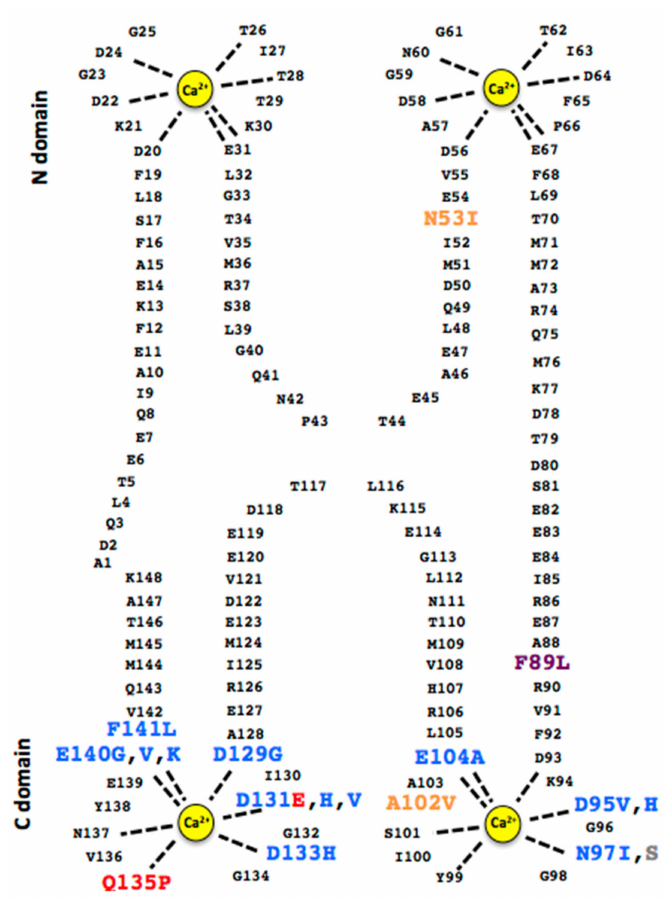
Figure 1. 2D schematic of CaM displaying all reported disease associated mutations. Mutations are color coded as follows: LQTS , CPVT , IVF , bothLQT / CPVT , CALM1 = CPVT, CALM2 = LQTS